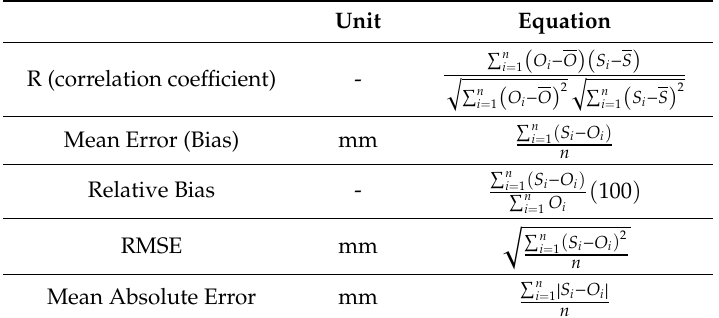
Table 1. Summary of statistical indices used to evaluate the satellite precipitation products (S i : satellite estimates, O i :